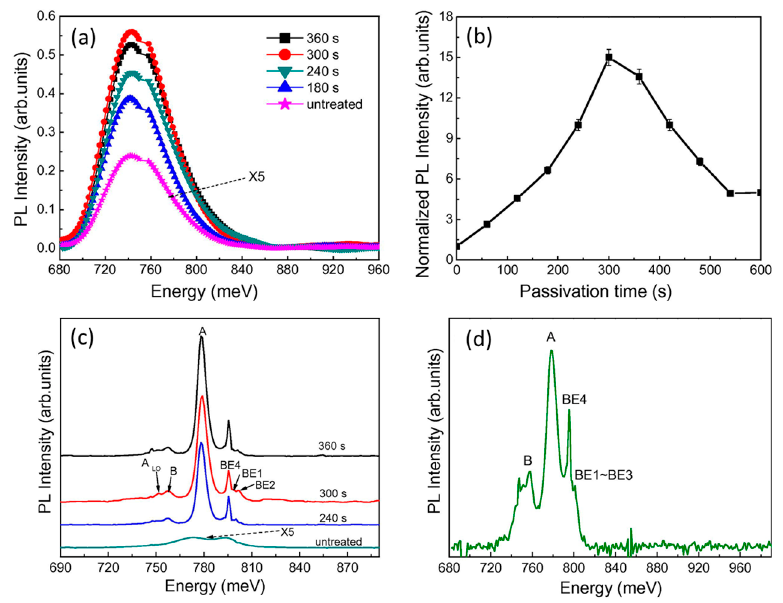
Figure 11. Passivation time dependence of the emission intensity of the GaSb samples, ( a,b ) shows the PL spectra of the untreated GaSb and the passivated GaSb in (NH 4 ) 2 S solution for different passivation times, ( c ) shows the low temperature PL spectra of GaSb and passivated GaSb, ( d ) logarithmic PL spectrum of GaSb sample at 10 K. Reproduced with permission from [8], copyright NORTH-HOLLAND (2013).